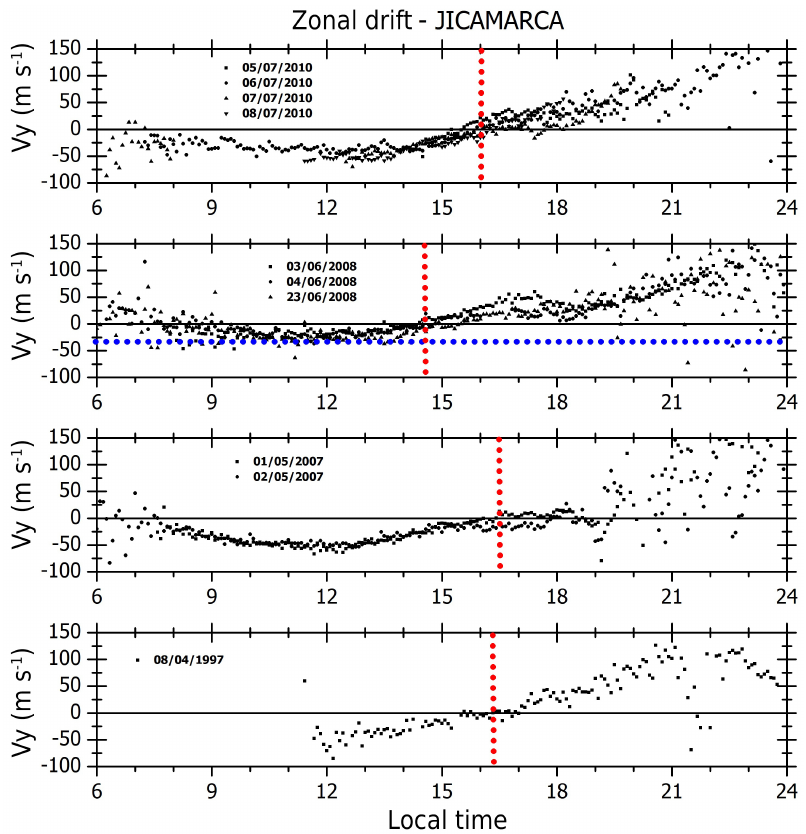
Figure 3. The zonal plasma drifts for different solar minimum activity epochs. The vertical dotted lines indicate times of the reversal of the drift to east in the afternoon, which, during June 2008, occurred earlier when compared with other solar minimum periods. The horizontal dotted line in the 2008 plot indicates the low intensity of the zonal drift during this